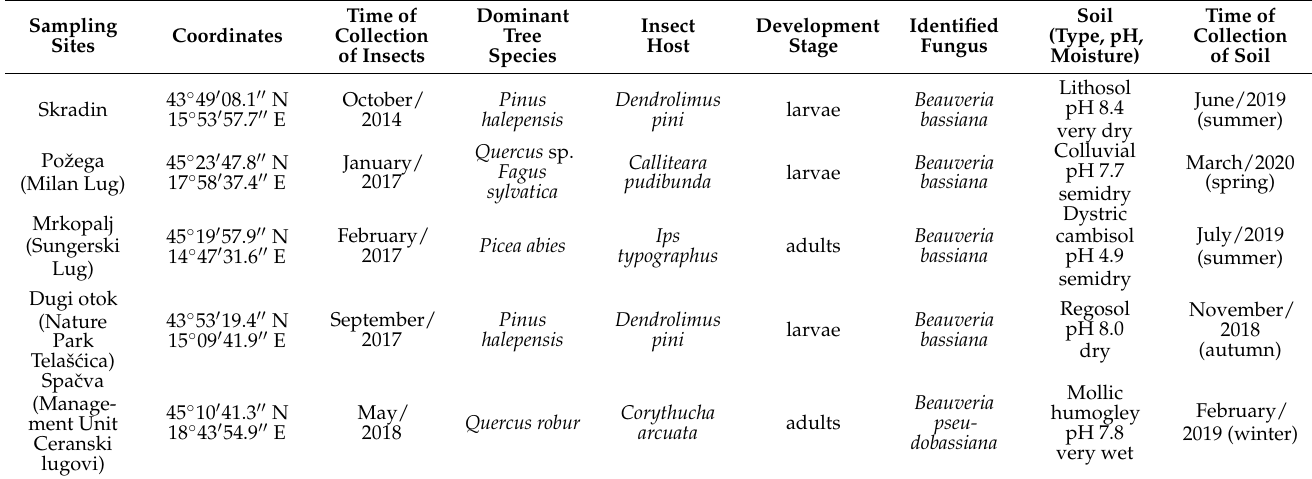
Table 1. Information on sampling sites in